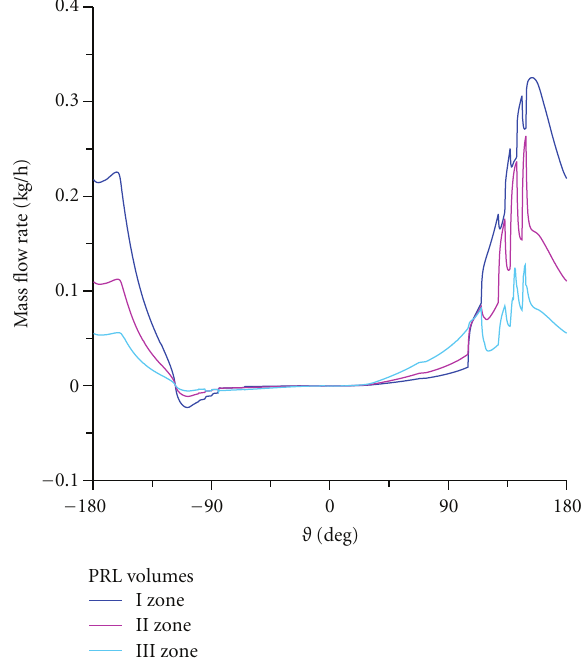
Figure 19: Mass flow rate in PRL volumes, β = 8, flutter